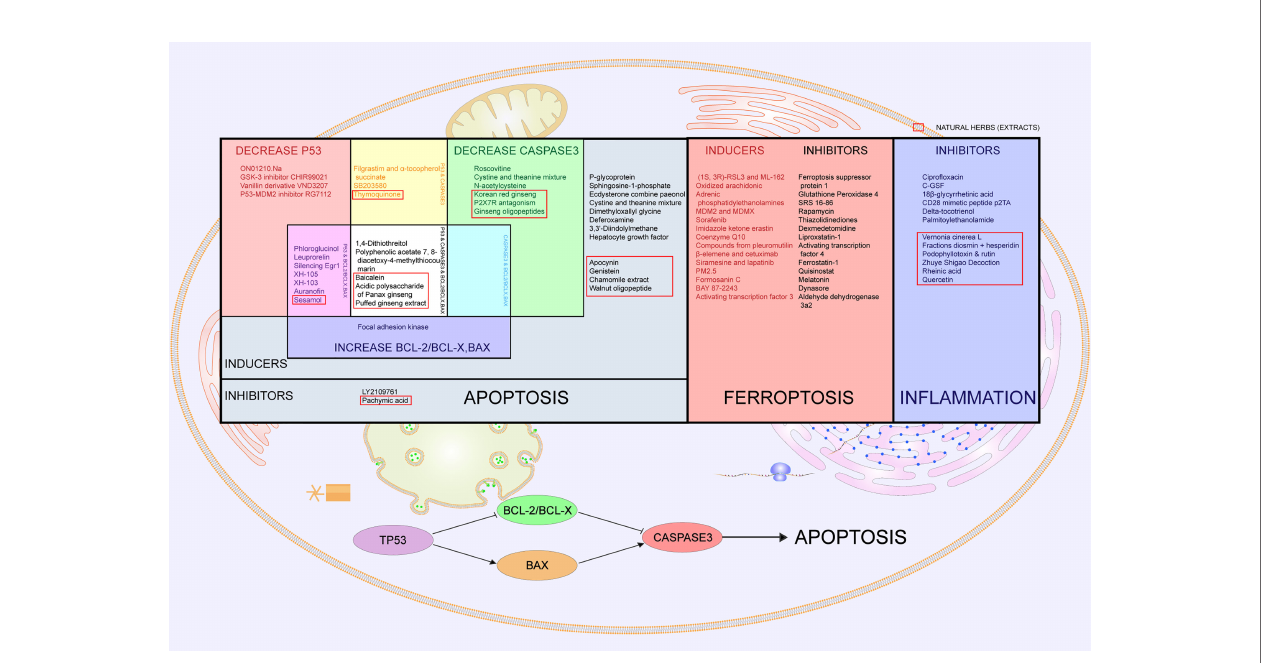
FIGURE 4 | Cell death- and in fl ammation-related drugs and countermeasures in radiation-induced digestive injury. Cell death-related drugs and countermeasures are divided into apoptosis and ferroptosis. In the left part of the table labeled “ Apoptosis ” , all listed drugs prove to be effective in radiation-induced digestive injury. Grey part represents apoptosis inhibitors and inducers with no speci fi c targets. The red part represents drugs that decrease p53, and the green part means drugs that decrease caspase3. Blue is for drugs that increase bcl-2/bcl-x or bax. Overlapping parts for two of the above three kinds of drugs are painted magenta, yellow and cyan respectively, meaning that drugs regulate both two factors. White stands for drugs with all of three functions. Clustering of drugs regulating p53, bcl-2/bcl-x, bax and caspase 3 implies that the p53 pathway is activated. The middle square painted red lists inducers and inhibitors of ferroptosis. The right square in blue lists inhibitors of in fl ammation that alleviate radiation-induced digestive injury. Natural herbs are selected with red